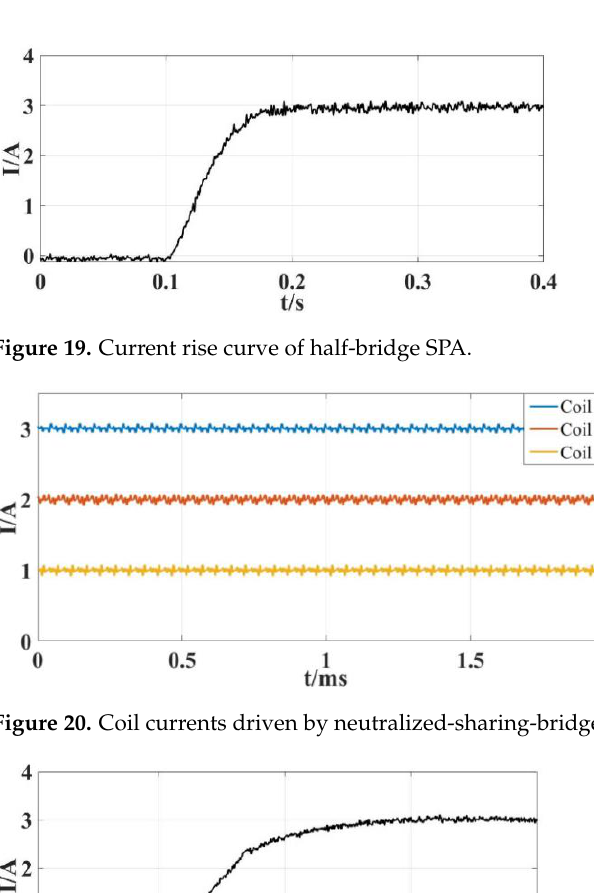
Figure 18. Coil currents driven by half-bridge SPA.